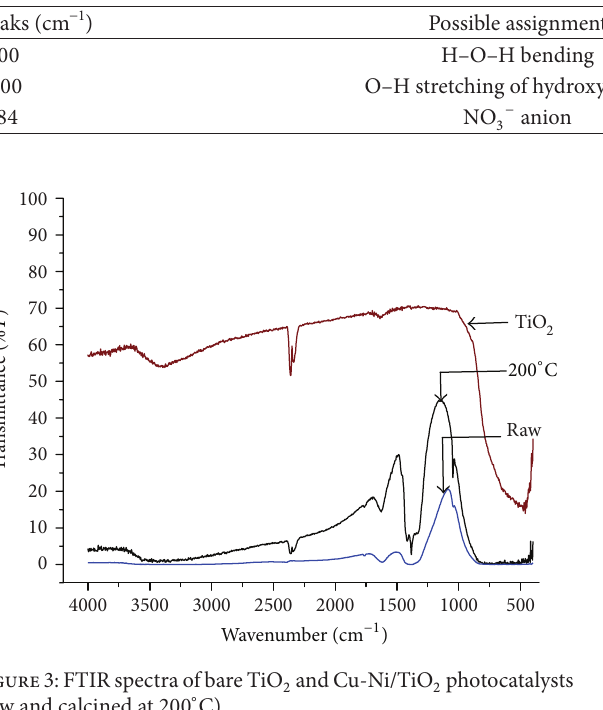
and Cu-Ni/TiO photocatalysts. 2 2